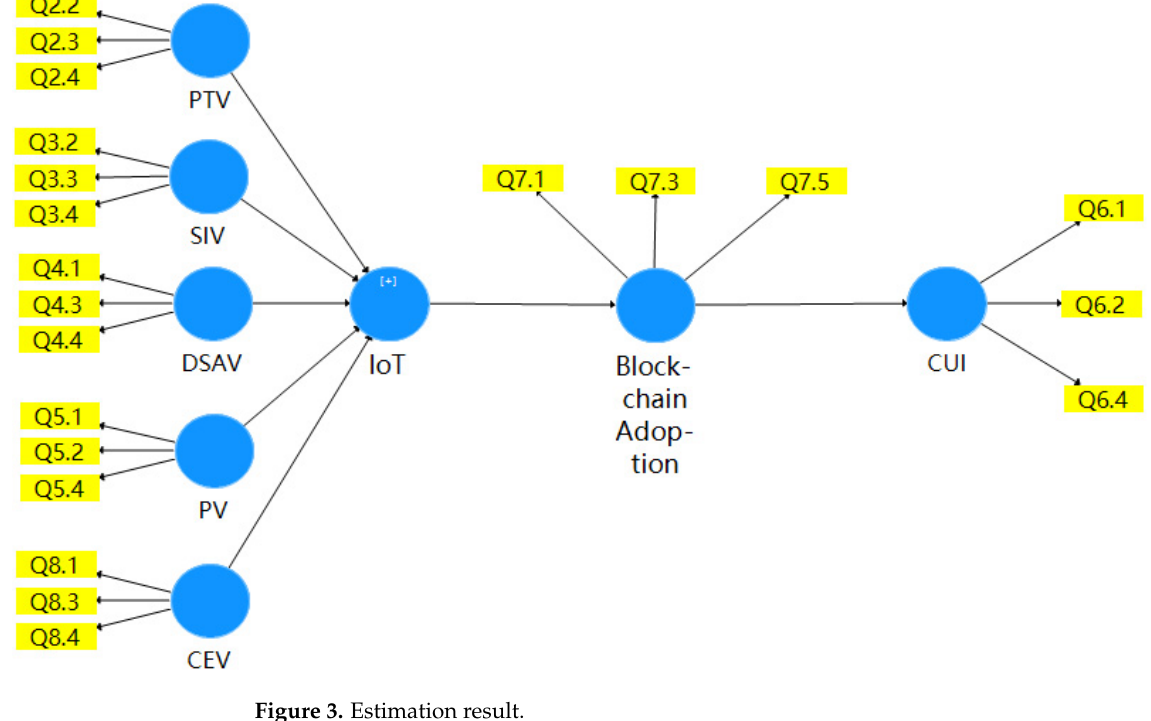
Figure 3. Estimation result.